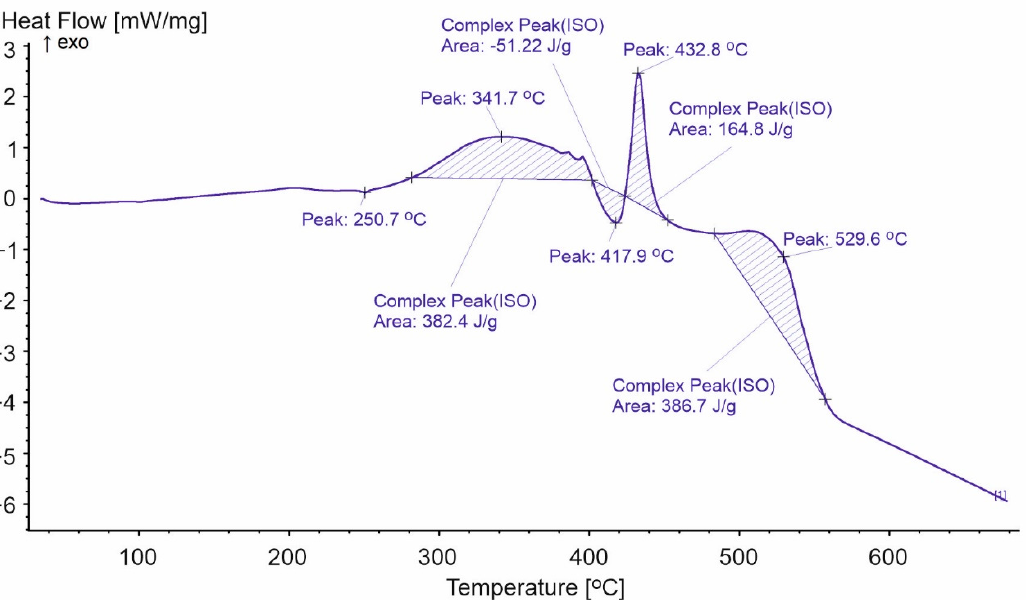
Figure 9. DSC curve for PS ‐